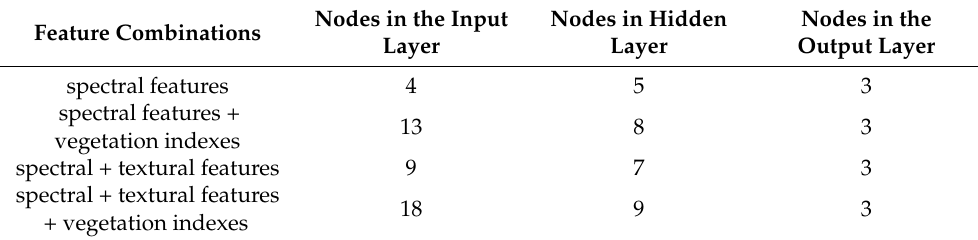
Table 6. The number of nodes for four kinds of feature